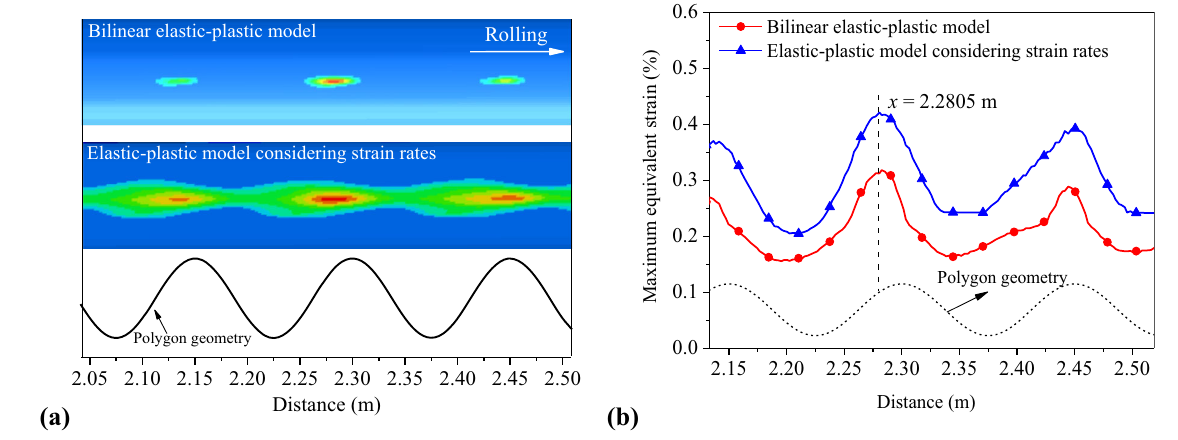
Fig. 8 a Equivalent plastic deformation and b equivalent strain calculated by different material